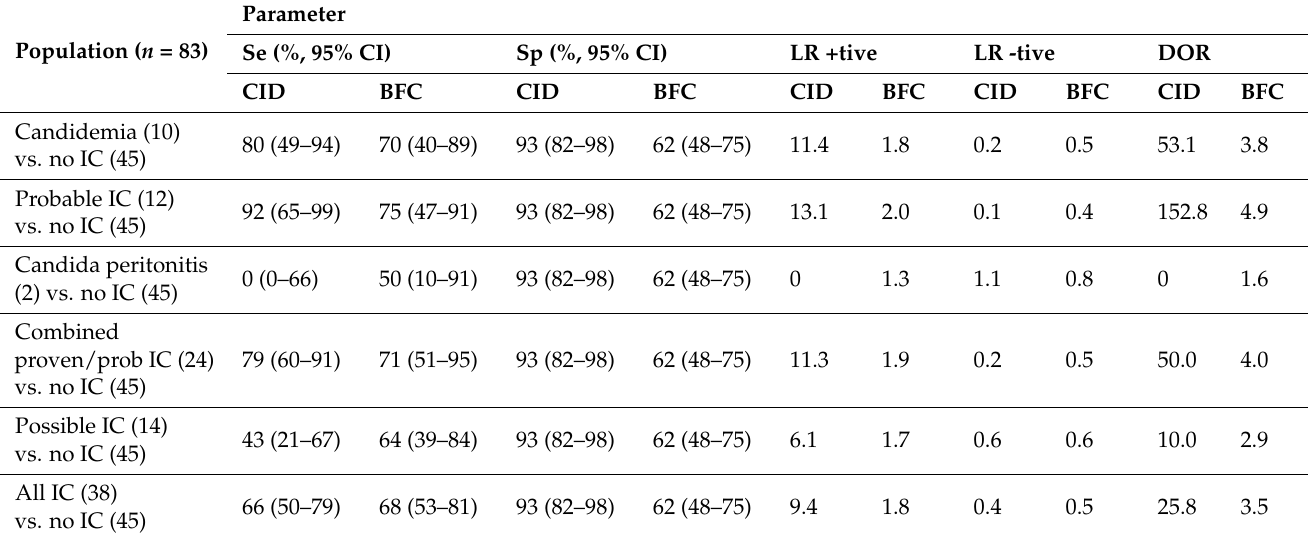
Table 1. Retrospective performance of the OLM Cand ID real-time PCR when testing serum in comparison to routine prospective testing using the Bruker Fungiplex Candida